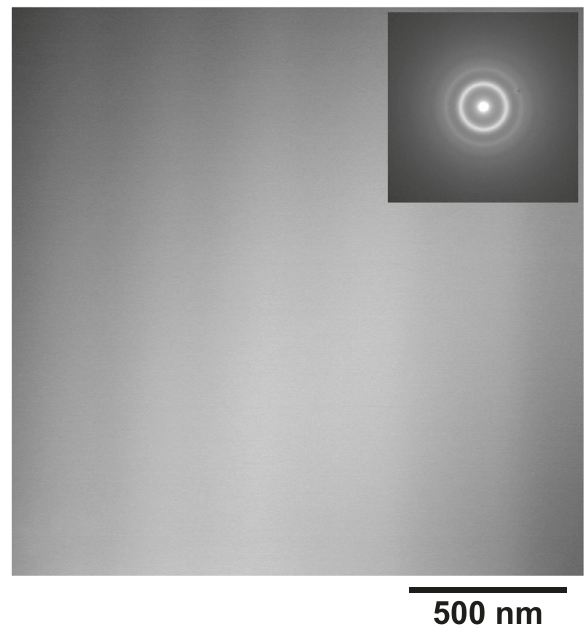
Fig. 4 Low-magni fi cation BF-STEM images of the pHPQ Zr 50 Cu 40 Al 10 sample synthesized at 5.5 GPa and 880 K. Inset is the selected area diffraction pattern of the image. There is no contrast in the BF-STEM image and there are no spots corresponding to the crystal in the diffraction pattern, indicating no typical ordering at the 100-nm scale in the pHPQ sample. The vertical stripes are the processing trace by the focused ion